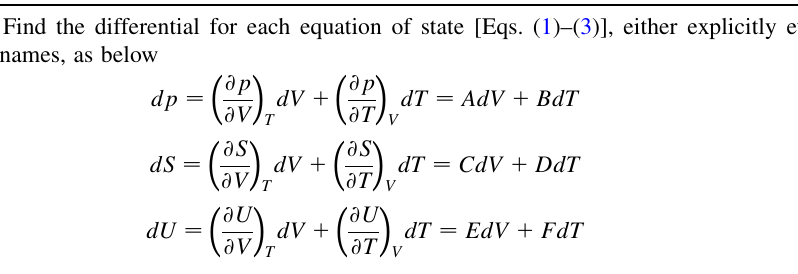
2. Multiply Eq. (6) by D and Eq. (7) by (cid:1) B , then add to find dV in terms of dp and dS